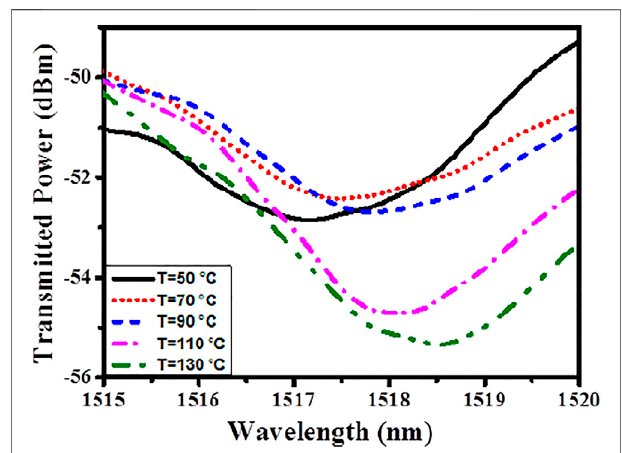
FIGURE 6 | Shift in interference pattern with temperature.